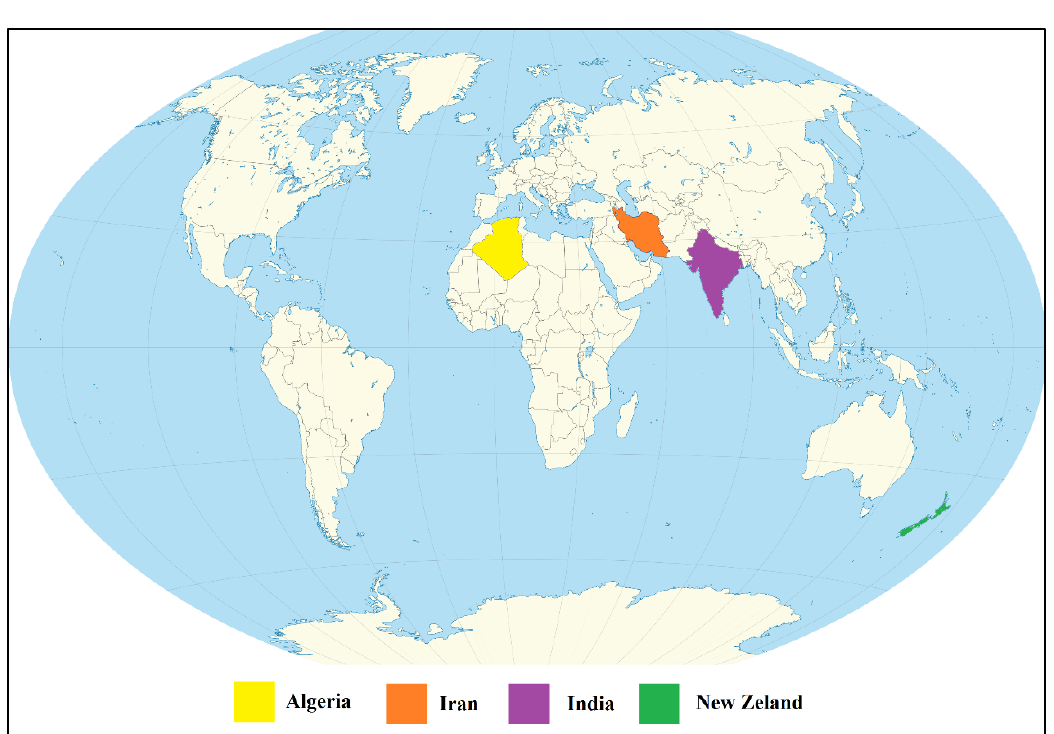
Figure 6. Most Productive Countries in the Map.